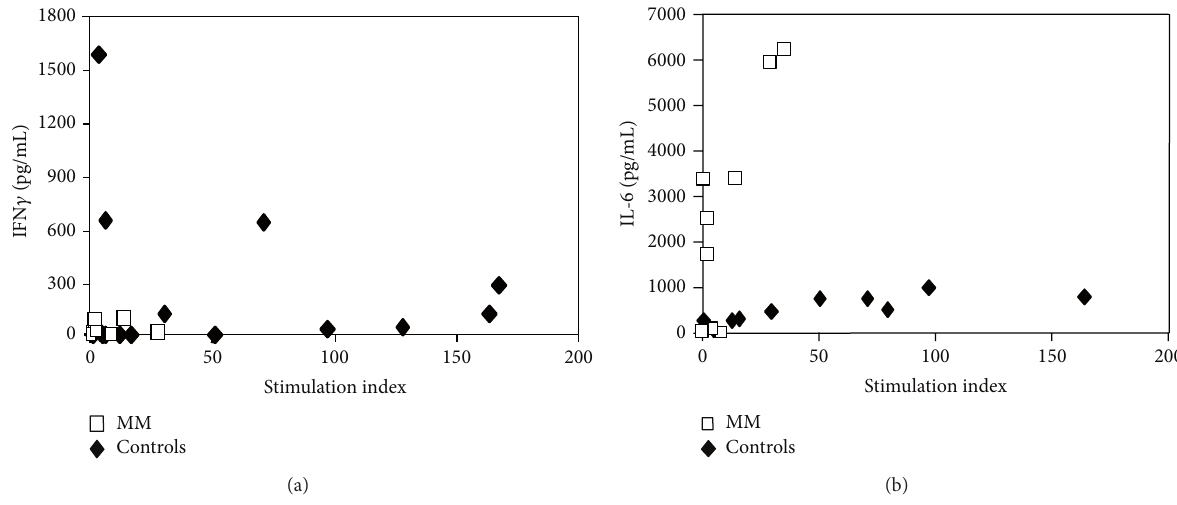
Figure 1: Proliferation, IFN 𝛾 , and IL-6 induction by CD38 mAb engagement in PBMC obtained from MM patients or healthy individuals. PBMC (2 × 10 5 cells/well in 0.2 mL) obtained from MM patients or healthy controls were cultured in the presence of agonistic anti-CD38 IB4 (20 𝜇 g/mL). Proliferation (SI) was measured after 5 days by 3 H-Thymidine incorporation. IFN 𝛾 (pg/mL) and IL-6 (pg/mL) were measured by ELISA after 18hours of culture. (a) Dispersion of proliferation (SI) respect to IFN 𝛾 (pg/mL) values in each of all PBMC donors tested. (b) Dispersion of proliferation (SI) respect IL-6 (pg/mL) values in each of all PBMC donors tested. For the definition of SI and technical details, see text.